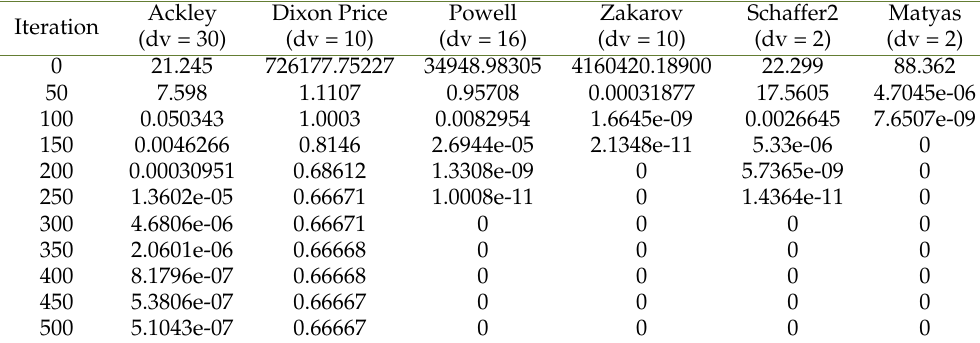
Table 8. Convergence of Sine (AB) towards Optimal [a=1.5; 500 iterations; one trial]